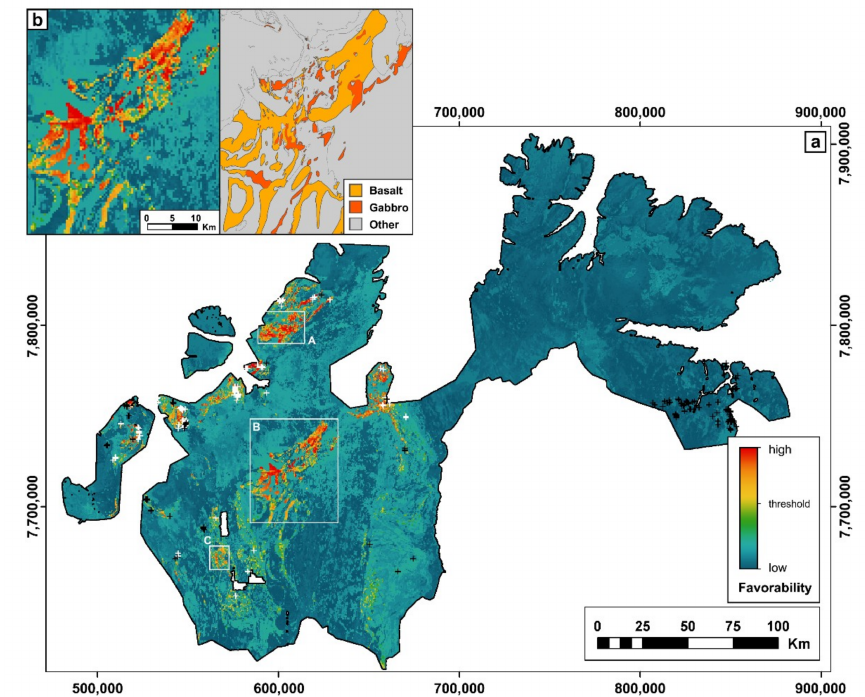
Figure 8. ( a ) Favorability measure of Cu-rich mineralization estimated from the radial basis function neural network for the Finnmark region (500-m cell resolution). Favorability values derive from the model’s prediction value range ( − 0.73–0.73). Shades of yellow, orange and red (equal or above the threshold) represent areas favorable for Cu mineralization. Locations of “deposit” and “non-deposit” sites, which were used as training and validation data, are shown by white and black crosses, respectively. Zones A (within the Repparfjord Tectonic Window), B and C (both within the Kautokeino Greenstone Belt) are examples of prospective zones unveiled by the model, which do not contain any local training or validation data. ( b ) Predictions in zone B compared with